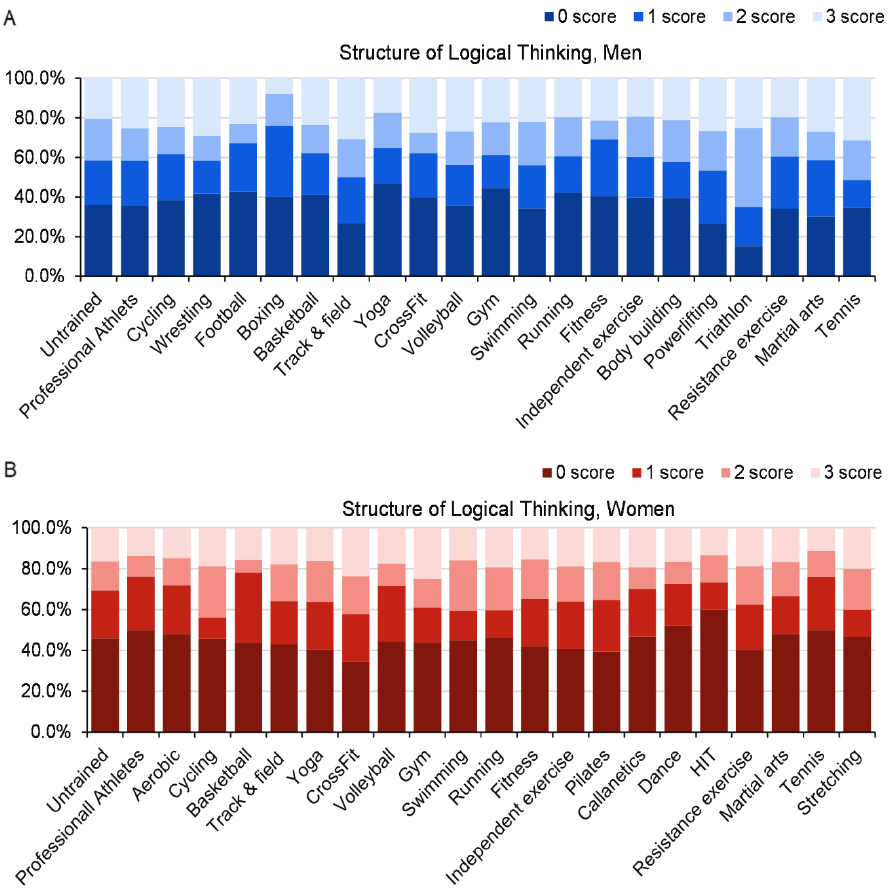
Figure 2. Ability to solve three logical thinking tasks among men ( A ) and women ( B ) according to the type of exercise . The numbers at the bottom (0 – 3) indicate the number of tasks solved